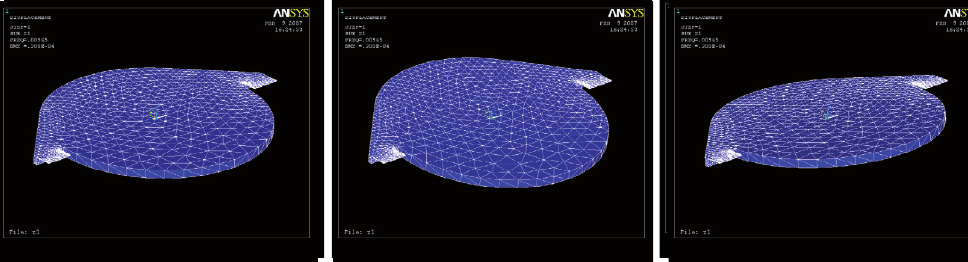
Fig. 11. First mode of the resonance frequency of the